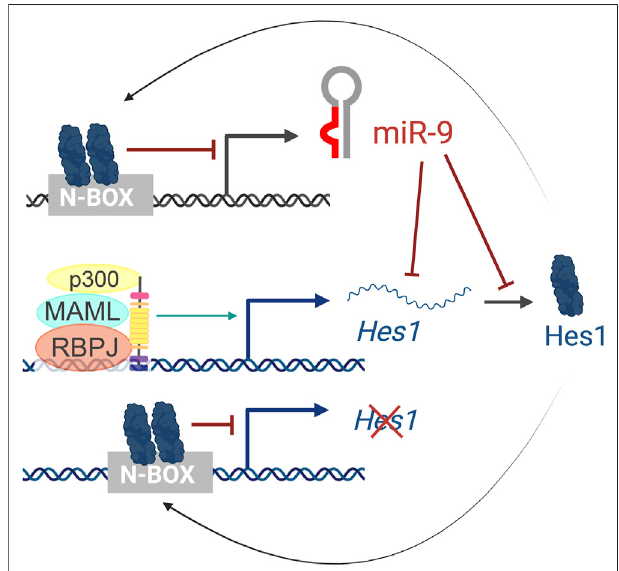
FIGURE 6 | The Hes1/miR-9 oscillator. Activation of the Notch pathway leads to the activation of Hes1 transcription. Hes1 protein then dimerizes and binds to N-box domains to repress its own expression as well as miR-9 transcription. In turn, miR-9 reduces Hes1 levels by controlling the stability of Hes1 mRNA and inhibiting its translation, resulting in oscillatory